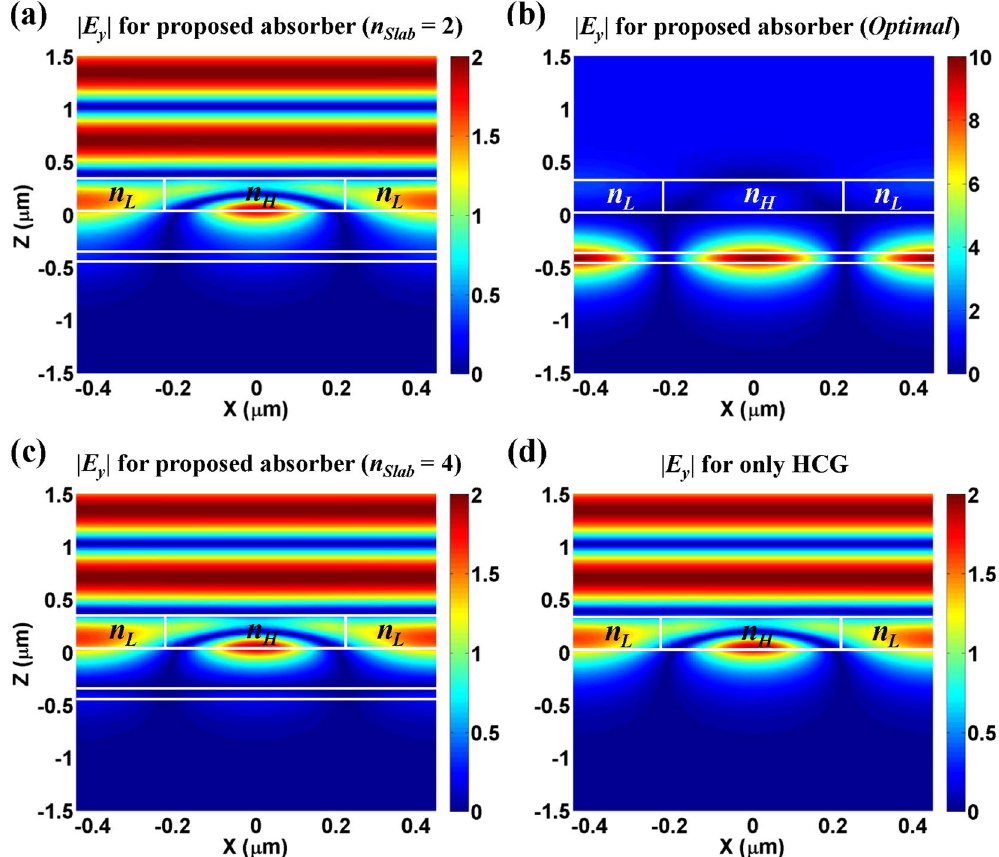
Figure 3. Electric field distributions (| E y |) at λ = 1.2805 μ m for the proposed “ triple - mode absorber ” with ( a ) n Slab = 2, ( b ) n Slab = 3 (optimal), ( c ) n Slab = 4, and for ( d ) a lossless HCG alone. Note that the remaining parameters are the same as those of the inset in Fig. 2(f); that is, d Grat = 0.32507 μ m, d Gap = 0.38691 μ m, and d Slab = 0.057335 μ m, and all calculations are conducted using